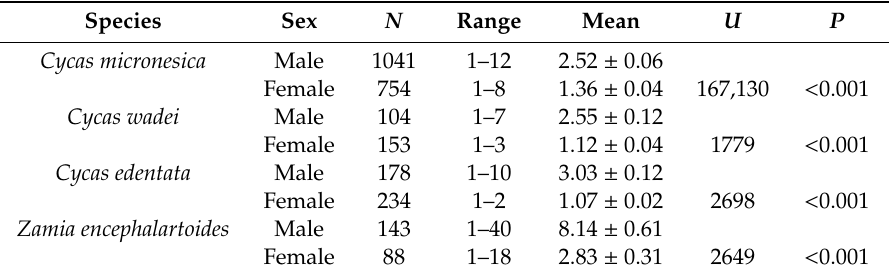
Table 1. The influence of sex on stem branching of four cycad species. Significance determined by the Mann–Whitney U test. Means ± standard